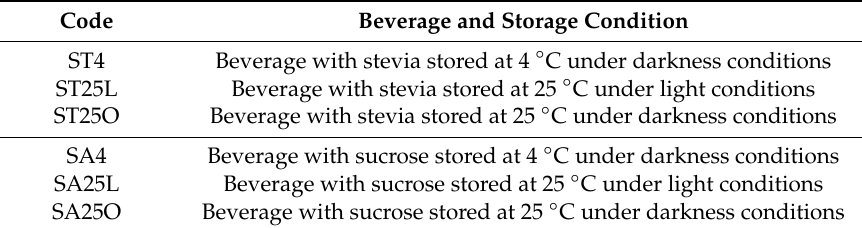
Table 1. Codification of samples included in the experimental